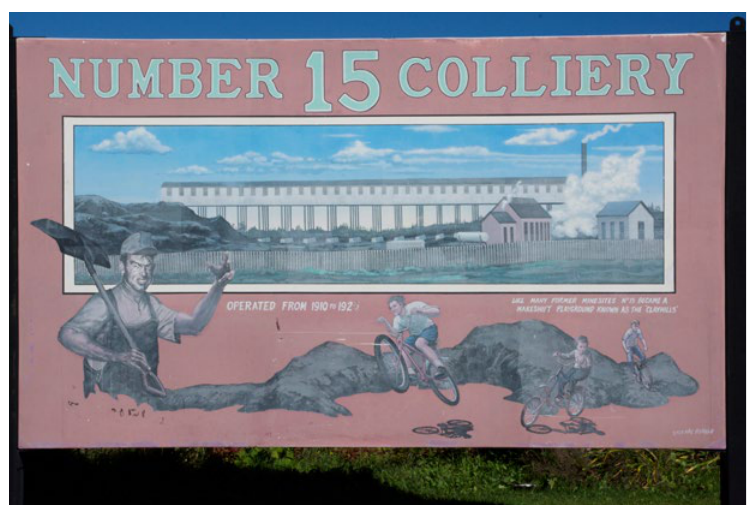
Figure 6. Number 15